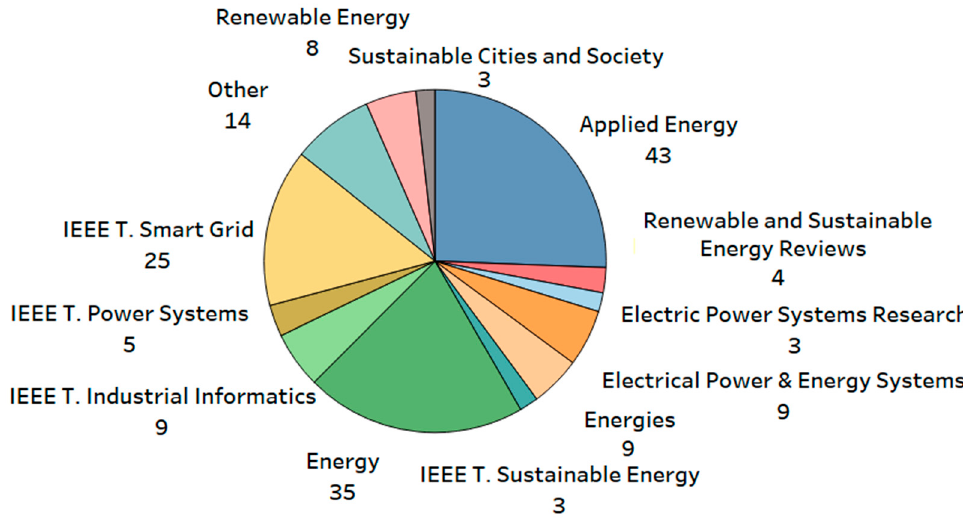
Figure 13. Number of articles in the pool by publishing journal. Self-elaboration. The last metric to be analyzed is citations. Most of the articles in the pool have been extensively cited, with a median citation count of 32.5 per article, and a mean citation count of 43.2 per article. If these numbers are put into perspective by considering the time that the article has been published, the pool achieves a median of 1.0 citations per month and a mean of 1.16 citations per month. Assuming the pool of articles is representative, it can be considered that the field is on good standing. The most cited article in the pool is [101], with a total count of 277 citations in January 2022. In Figure 14, the descriptive statistics of the article citations are presented.